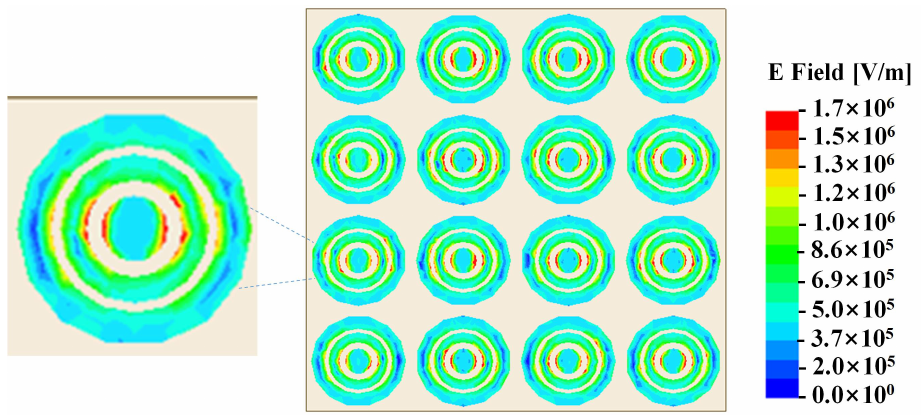
Figure 6. The simulated electric field distribution of the second graphene layer at f 2 = 6 THz.